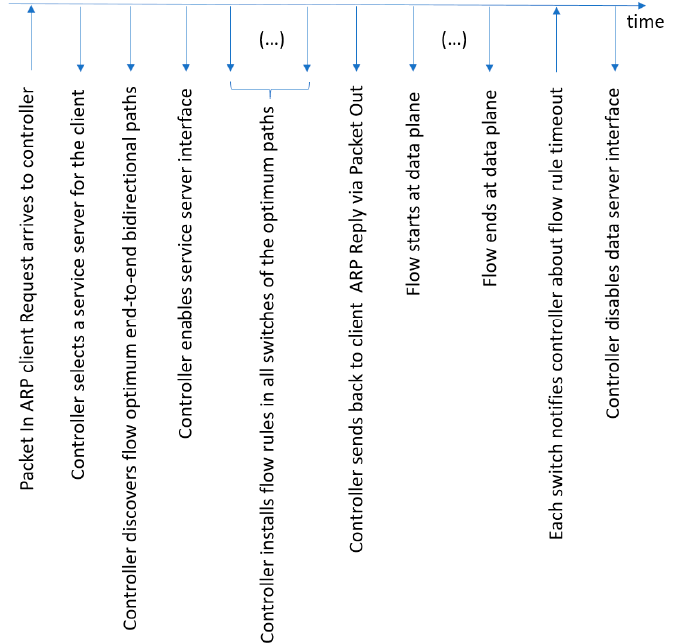
Figure 5. Timeline of system actions for the novel automatic (de)activation of edge servers using a proactive flow controller. Algorithm 1 The controller processes the initial ARP request associated to each flow. That message is used as a trigger to anticipate the bidirectional flow rules installation on all the involved switches in the end-to-end flow path with the minimum cost between the client and the elected server.